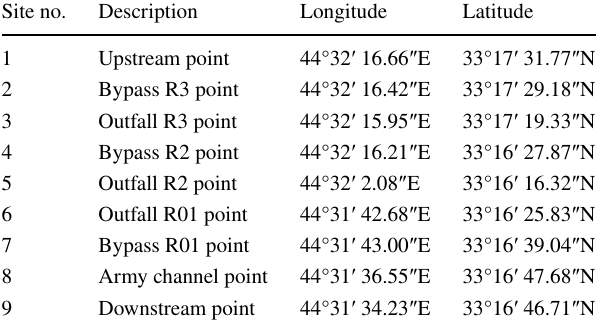
Table 1 Coordinates and description of sampling sites Site no.